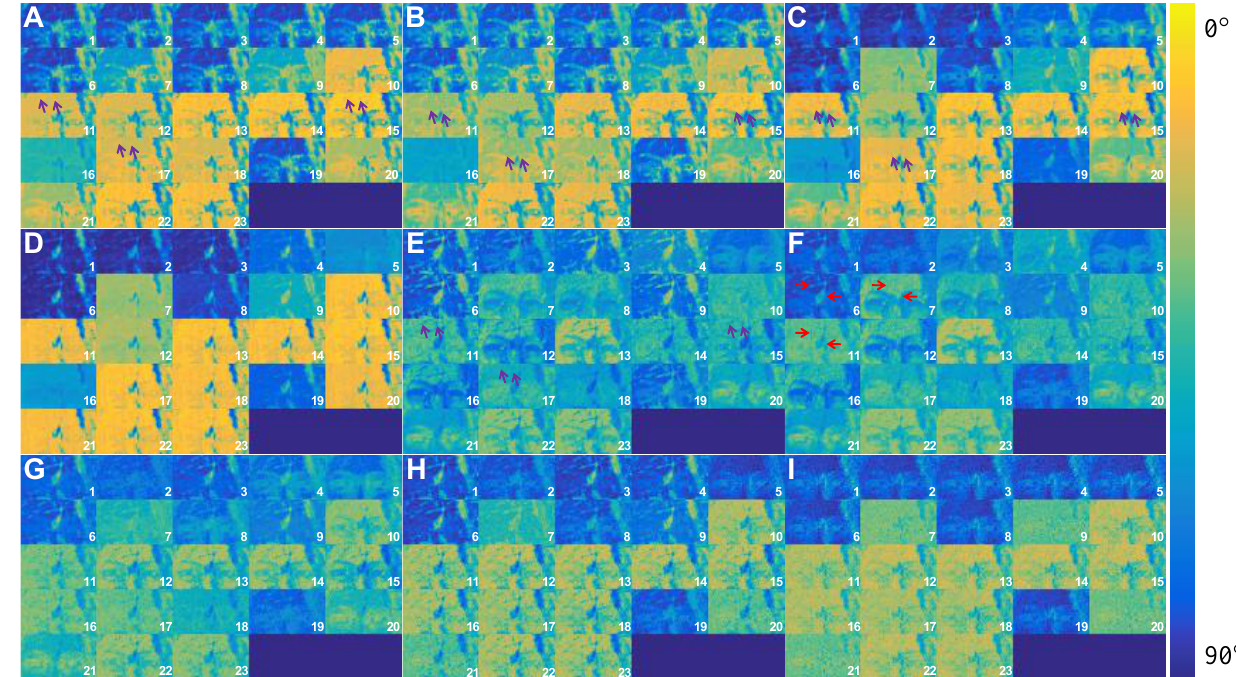
Figure 6. The sets of similarity maps, [𝐴] 𝑘 , for the isolated test spectra of the Gable of San Diego obtained following the abundance criterion. The numbers within the panels refer to Table 2, the letters to Table 5. The color bar illustrates the level of similarity (in terms of the angle between vectors). ( A ) shows [𝐴] 𝑘 , the set of similarity maps obtained without manipulating the spectra. ( B ) shows [𝐴] 𝑘 , obtained after the channels related to 10.5 keV series of Pb has been suppressed. ( C ) shows [𝐴] 𝑘 which depicts what happens on removing the Ca series at 3.7 and 4 keV and the Sr series at 14.1. ( D ) shows [𝐴] 𝑘 that follows the removal of Fe. ( E ) shows [𝐴] 𝑘 , the similarity maps after the removal of the 12.6 keV series of Pb. ( F ), [𝐴] 𝑘 , follows the removal of the 4.4 series of Ti. ( G ) reports [𝐴] 𝑘 , the similarity maps after the removal of the Hg series at 10 keV. ( H ), [𝐴] 𝑘 , shows what happens if Fe is completely deleted. ( I ), [𝐴] 𝑘 , corresponds to the removal of the residual Titanium series. Purple arrows in A – C and E and red arrows in ( F ) highlight the areas of interest discussed in the text.